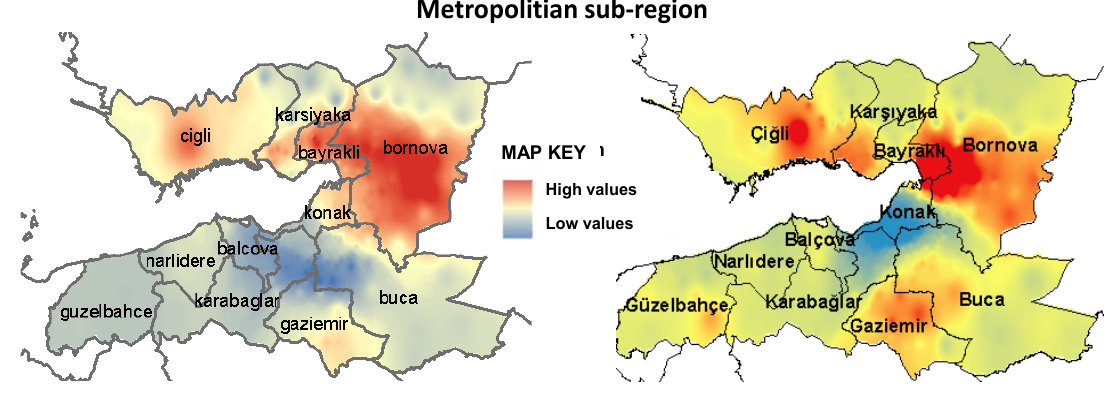
Figure 10 Agglomeration of service employment change in Metropolitan sub-region between 2009 and